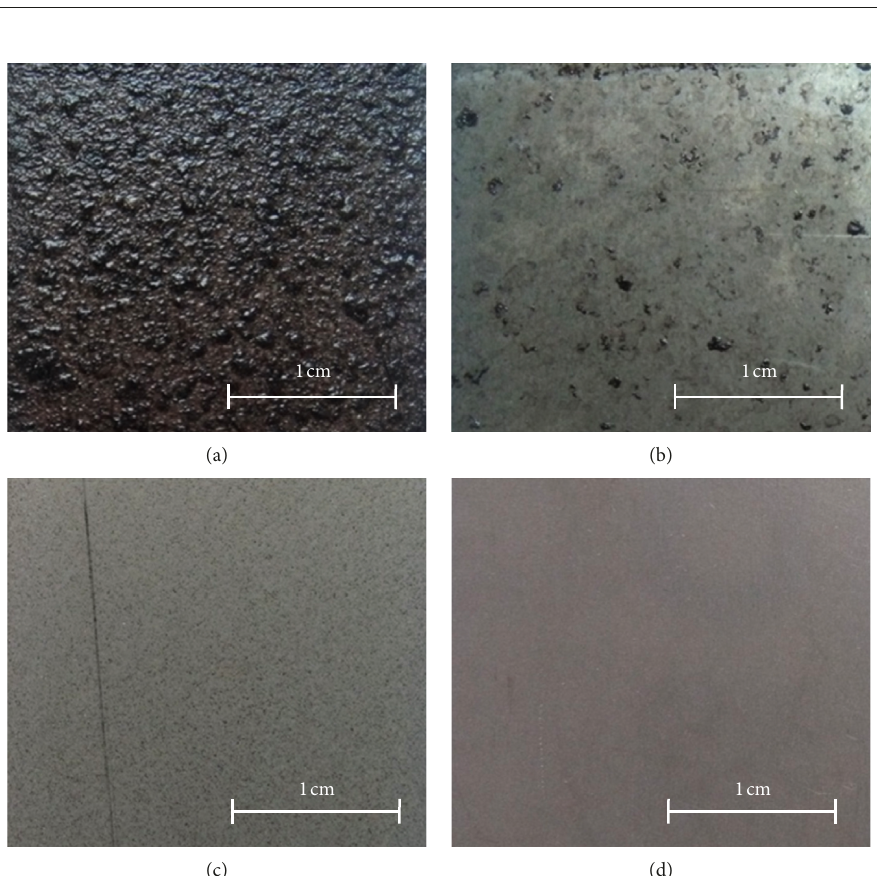
Figure 7: Contaminants accumulated on the cathode surface: in the bath without ER, (a) before DI water rinse and (b) after DI water rinse; in the bath with ER, (c) before DI water rinse and (d) after DI water rinse.